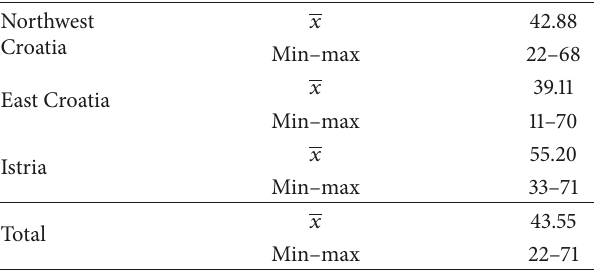
Table 1: Pollen analysis of acacia honey from Northwest Croatia, East Croatia, and Istria ( 𝑥 = % acacia proportion- Robinia pseudoa- cacia L